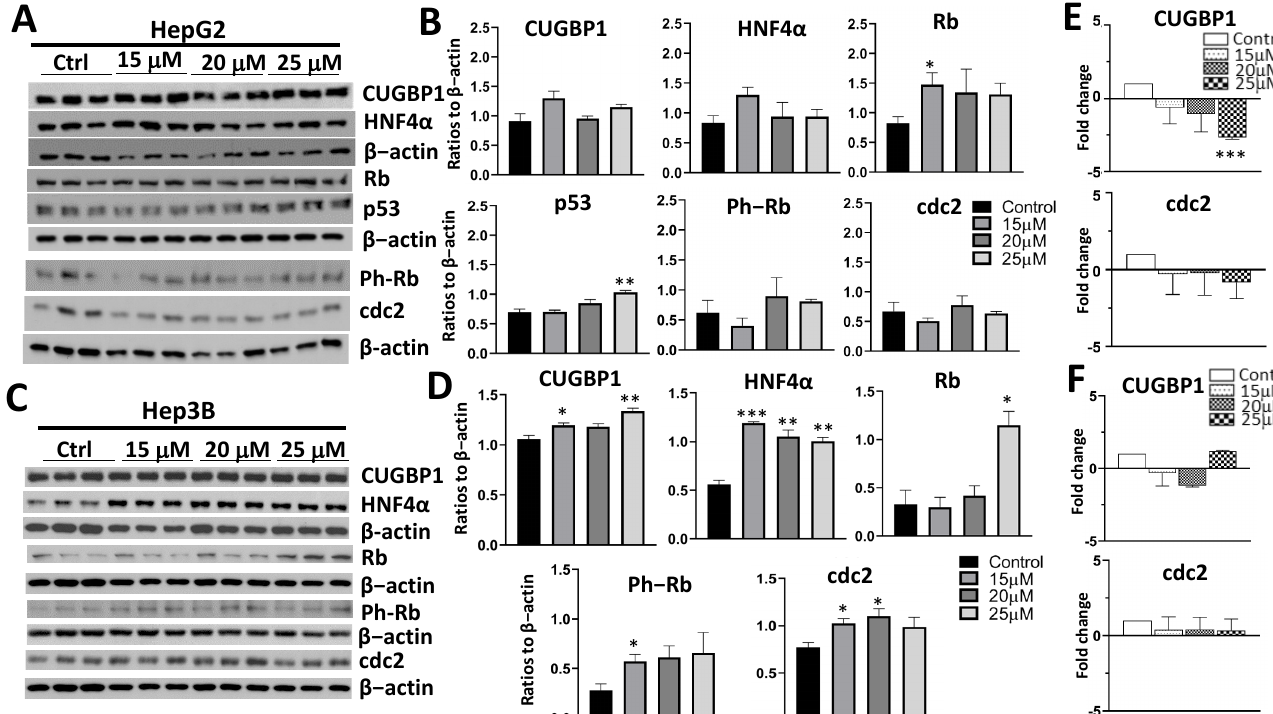
Figure 4. Treatment of cancer cells with cjoc42 derivative DK-1–7 demonstrated an increase in several tumor suppressor proteins but variable changes in cell cycle markers. ( A ) Western blots of HepG2 cells treated with increasing concentrations of DK-1–7. ( B ) Quantitation of the Western blot results of HepG2 cells treated with increasing concentrations of DK-1–7. There was an increase in p53 expression at 25 µ M ( p = 0.006) and Rb at 15 µ M ( p = 0.045). * = p < 0.05, ** = p < 0.01. ( C ) Western blots of Hep3B cells treated with increasing concentrations of DK-1–7. ( D ) Quantitation of the Western blot results of Hep3B cells treated with increasing concentrations of DK-1–7. There was a profound increase in HNF4 α at all concentrations (15 µ M, p < 0.001; 20 µ M, p = 0.003; 25 µ M, p = 0.002) and Rb at 25 µ M ( p = 0.017). CUGBP1 was also increased with treatment at 15 µ M ( p = 0.038) and 25 µ M ( p = 0.004). * = p < 0.05, ** = p < 0.01, and *** = p < 0.001. ( E ) QRT-PCR of HepG2 cells treated with DK-1–7. There was a statistically significant decrease in CUGBP1 mRNA expression at 25 µ M ( p < 0.001) but no change in cdc2. *** = p < 0.001. ( F ) QRT-PCR of Hep3B cells treated with DK-1–7. No changes seen in CUGBP1or cdc2 mRNA